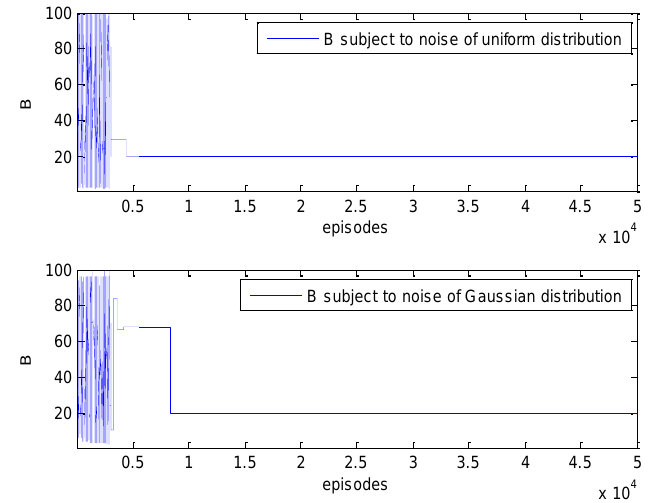
Figure 7. The episode training process with leakage of 0.01 ( B r = 15).